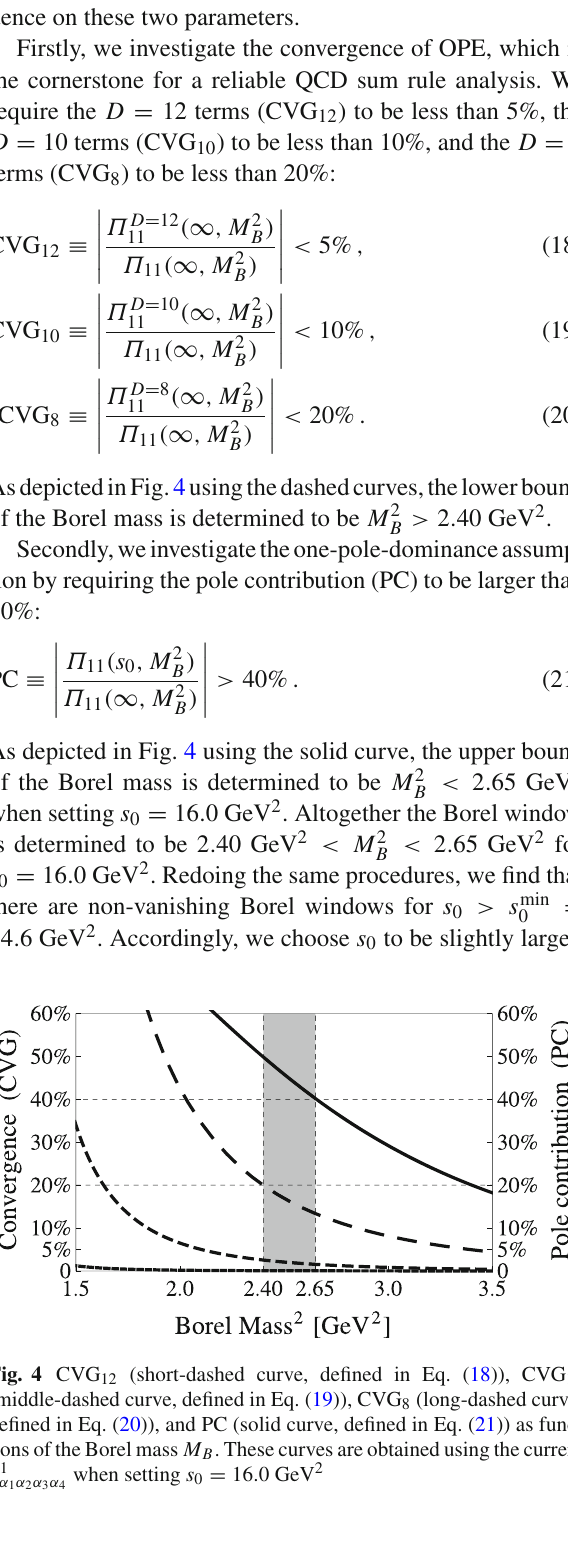
Fig. 4 CVG 12 (short-dashed curve, defined in Eq. (18)), CVG 10 (middle-dashed curve, defined in Eq. (19)), CVG 8 (long-dashed curve, defined in Eq. (20)), and PC (solid curve, defined in Eq. (21)) as func- tions of the Borel mass M B . These curves are obtained using the